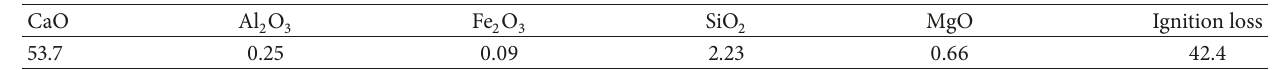
Table 7: Chemical components of heavy calcium carbonate (by percentage).